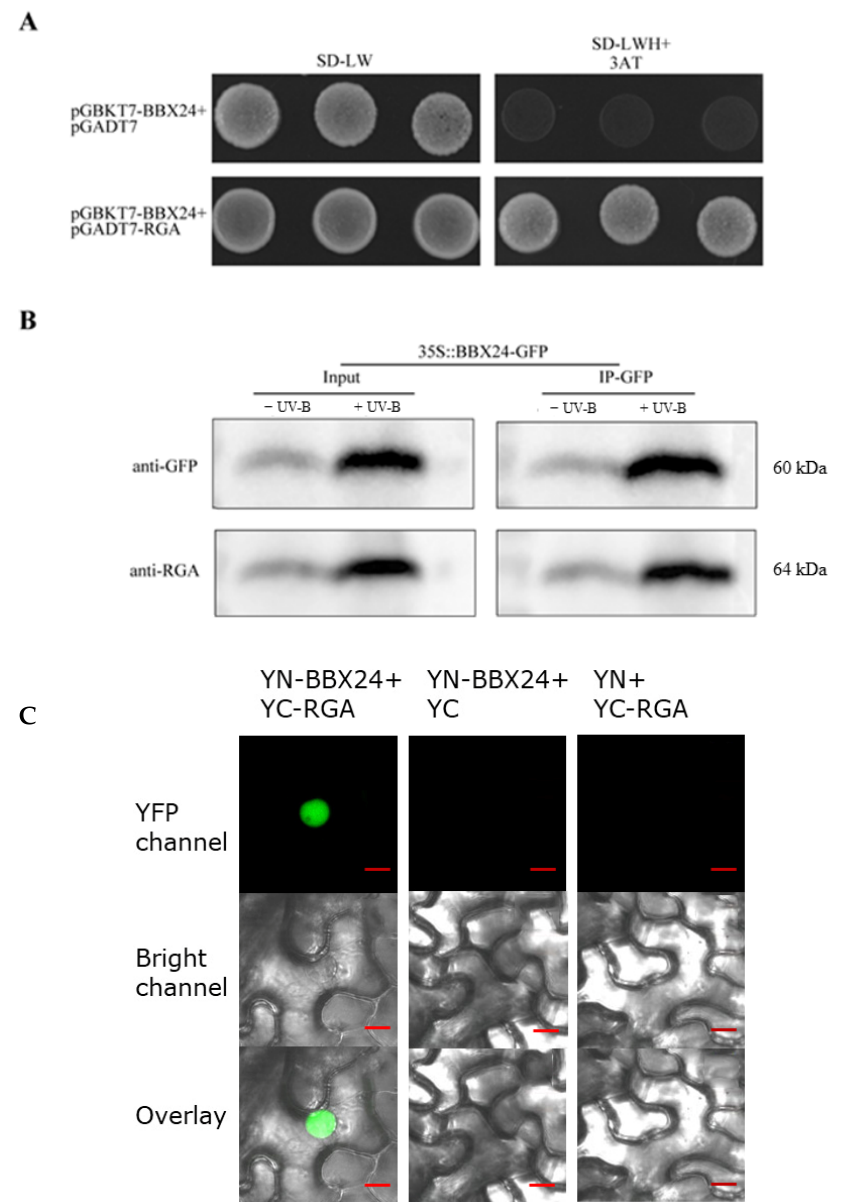
Figure 6. RGA physically interacts with BBX24. ( A ) Yeast was transformed with a bait and a prey construct. The bait vector constructs contain the GAL4-DNA binding domain fused with BBX24, and the prey vector constructs contain the GAL4-activation domain fused with RGA in the LexA system. Transformants were grown on SD/-Leu/-Trp/-Ade/-His (+X- α -gal) selective media. pGBKT7-BBX24/pGADT7-RGA was used as the positive control. ( B ) Co-immunoprecipitation assay using 7-day-old transgenic seedlings expressing 35S-BBX24-GFP treated with or without UV-B radiation for 6 h after treating with UV-B radiation for 10 h. Input: immunoblots showing the level of BBX24-GFP and RGA in the total protein extract. IP-GFP: immunoprecipitation products precipitated by the anti-GFP antibody. Total proteins (input) or immunoprecipitation products were probed in immunoblots with antibodies to GFP or RGA. ( C ) A BiFC assay was used to reconfirm the interactions between BBX24 and RGA. Full-length BBX24 and RGA were fused to the split of N- or C-terminal (YFP-N or YFP-C) fragments of YFP. Unfused YFP N-terminal (YFP-N) and YFP C-terminal (YFP-C) were used as negative controls. Merge, merged images (overlay) of the YFP channel and bright field channel. Scale bars: 10 µ m. Fluorescence signal was detected by confocal